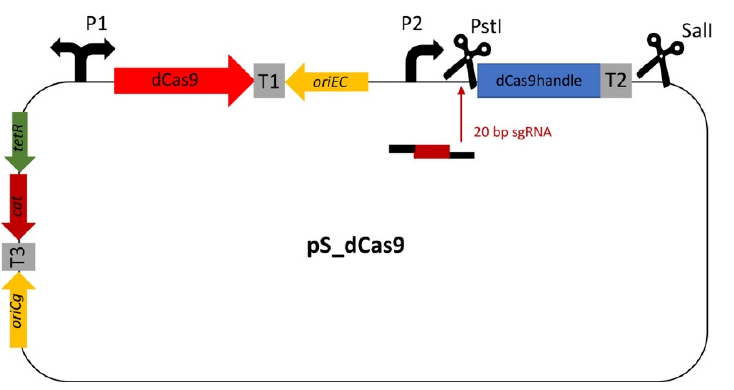
Figure 1. Construction of the dual-inducible CRISPRi expression plasmid pS_dCas9. Adapted pRG_dCas9 plasmid carrying the dCas9 handle followed by the terminator from S. pyogenes amplified from plasmid piCas between the PstI and SalI restriction sites. A 20 bp sgRNA sequence can be inserted in the PstI cloning site. For multiplexing of more than one specific sgRNA, the restriction site SalI after the first sgRNA-cs can be used. It has chloramphenicol resistance. P1: tetR/tetA